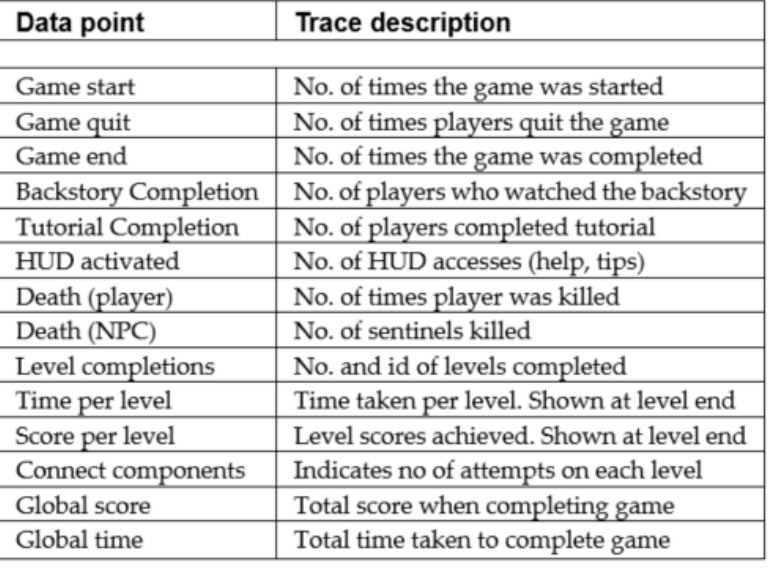
Fig. 8. Extracted traces selected for further in-game